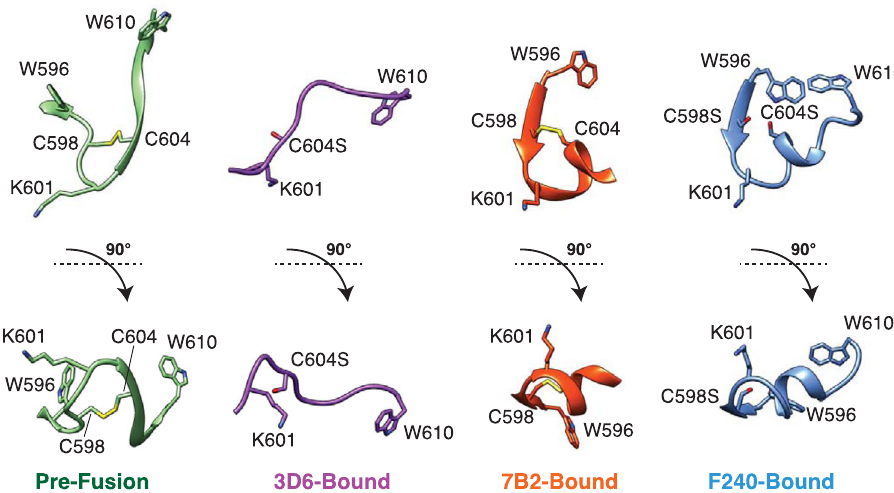
Fig. 5 Conformations of the HIV-1 gp41 PID motif. Comparison of the PID region (residues 596 – 610) in the pre-fusion HIV-1 gp160 (PDB: 6DE7), Fab 3D6-bound, Fab 7B2-bound (PDB: 4YDV), and Fab F240-bound conformations. HIV-1 PID residue S598 (labeled C598S) and S604 (labeled C604S) are shown here in stick